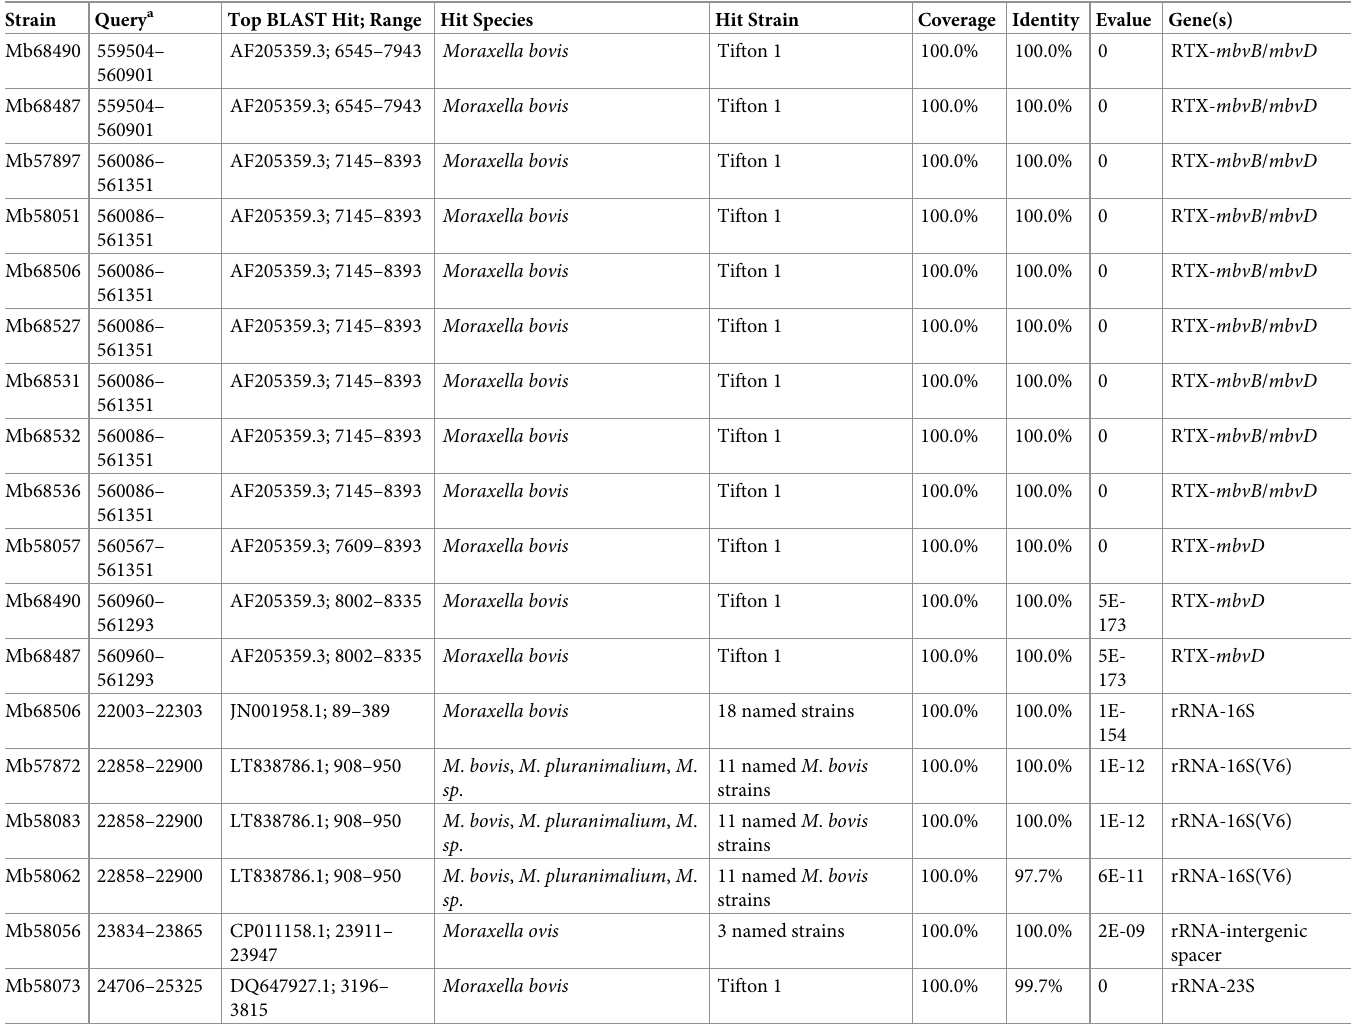
Table 2. Interspecies recombinant sequences at the repeats-in-toxin and ribosomal RNA loci. Strain Query